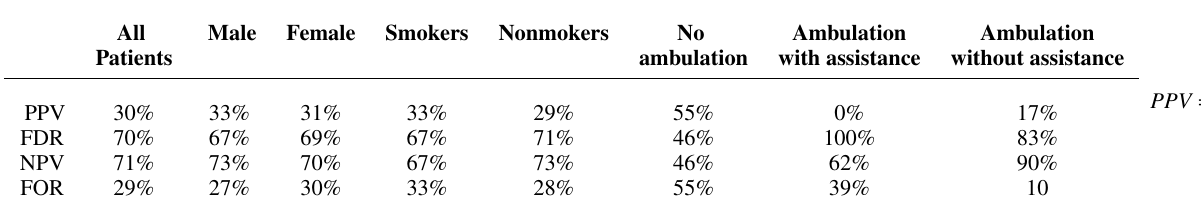
Table 3. Table 3. Patient Accuracy When Responding Yes or No to the Question Do you think you broke your ankle?